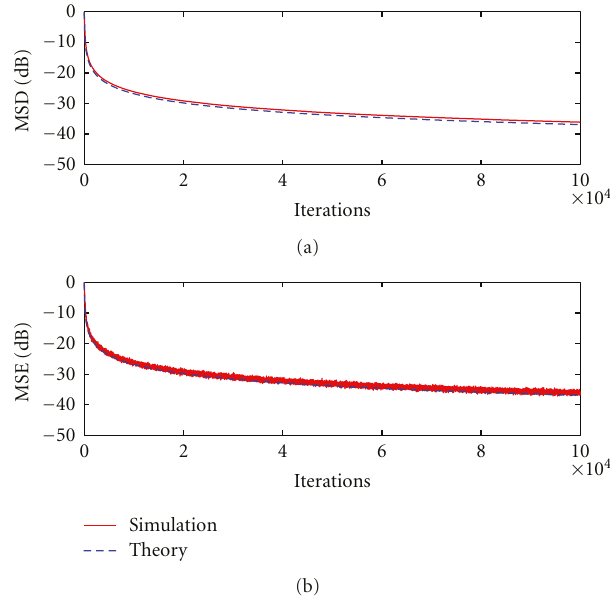
Figure 6: Theoretical and simulated MSD (a) and MSE (b) learning curves of the SRLMF algorithm using white Gaussian regressors with SNR =